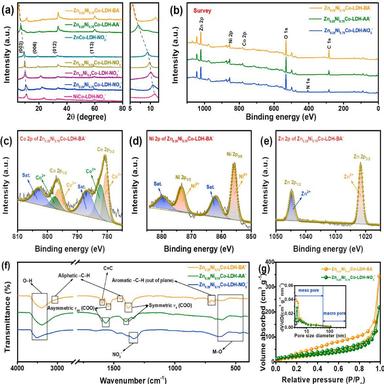
(a) XRD patterns of the samples. (b) Survey spectra of Zn0.25Ni0.75Co-LDH-BA– /AA– /NO3 − and high-resolution XPS spectra of (c) Co 2p, (d) Ni 2p, and (e) Zn 2p of Zn0.25Ni0.75Co-LDH-BA– . (f) FT-IR spectrum of Zn0.25Ni0.75Co-LDH-BA– /AA– /NO3 − . (g) N2 absorption-desorption isotherm of Zn0.25Ni0.75Co-LDH-BA– and Zn0.25Ni0.75Co-LDH-NO3 – (inset: pore-size distribution).